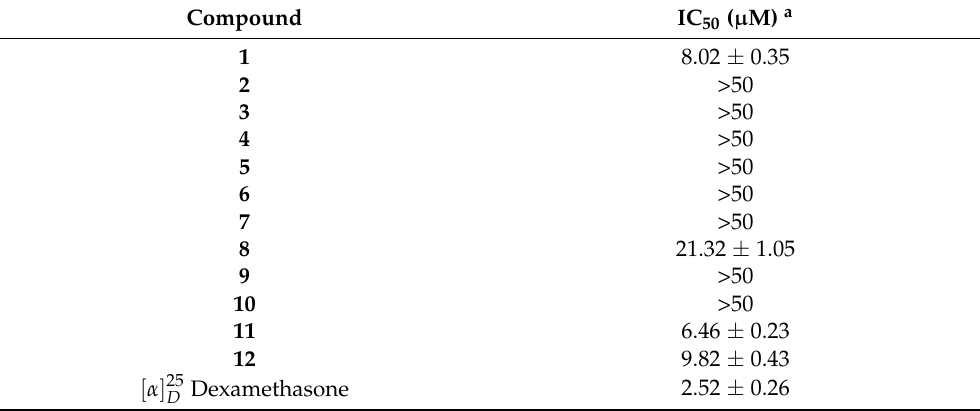
Table 3. The anti-inflammatory activities of compounds 1 – 12